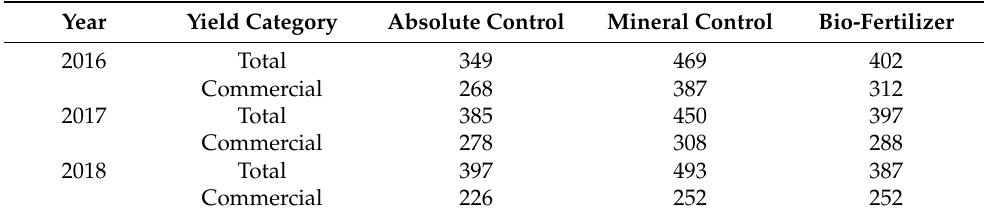
Table 10. Unit productivity of rainfall water during the tomato growing season, kg fruits per 1 mm. Year Yield Category Absolute Control Mineral Control